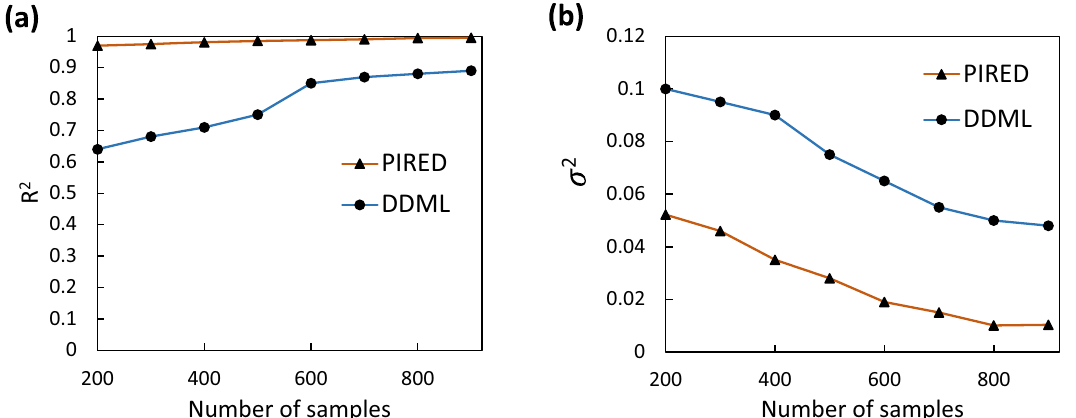
Fig. 2 Data size reduction of training of PIRED. Effect of data size on ( a ) the R 2 score and ( b ) σ 2 for PIRED and DDML networks.